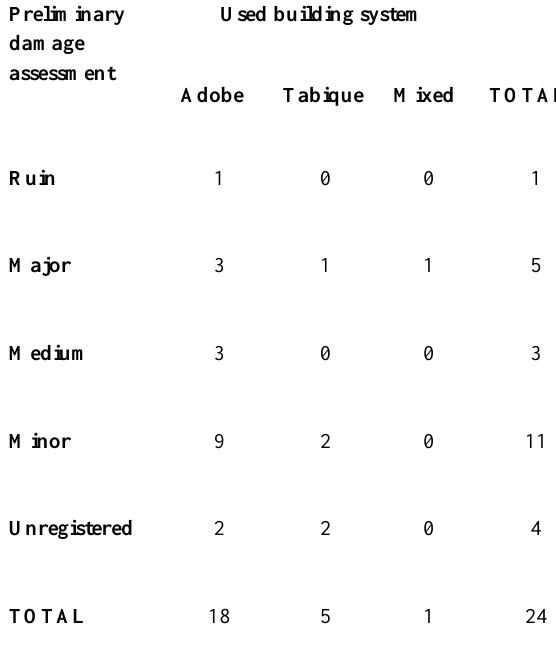
Table 2. Summary of preliminary damage assessment in cadastered furnace